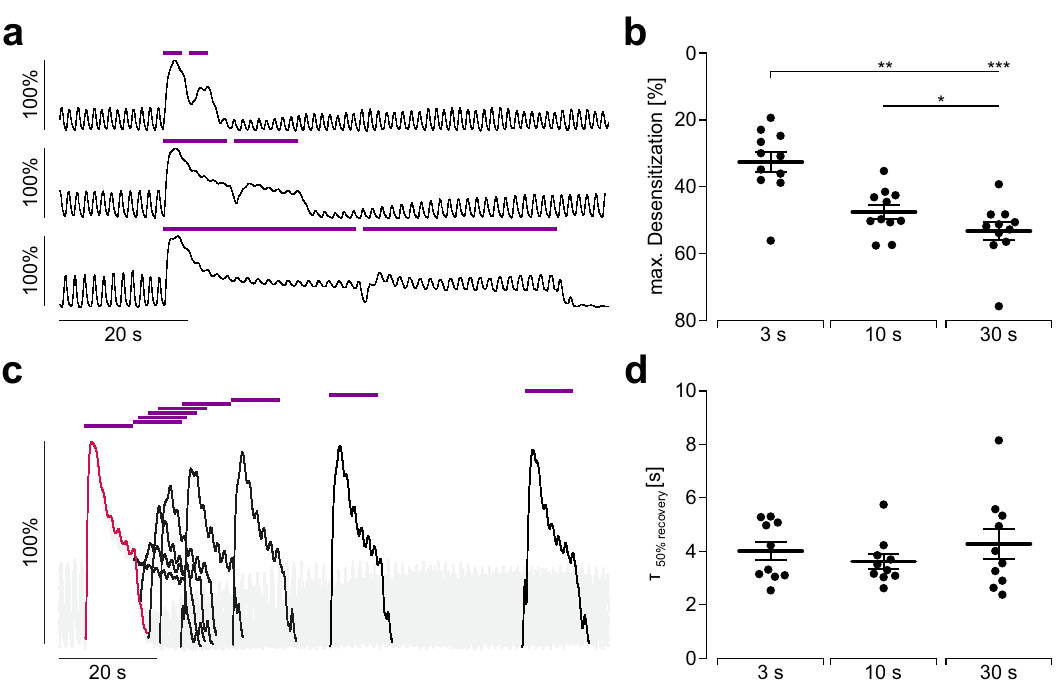
Fig. 10 Desensitization and recovery from desensitization of light-induced force in the small intestine. a , b Representative traces ( a ) and aggregated data ( b ) of isometric force measurements showing the maximum desensitization (relative decrease) of light-induced isometric force in dependence of the applied pulse duration (violet bars, 1 mW/mm 2 , from top to bottom: 3 s, 10 s, 30 s). Statistical analysis was performed with repeated measurements one- way ANOVA with Tukey ’ s multiple comparison test ( N = 4, n = 11; p(3 vs. 10 s): 0.0015; p(3 vs. 30 s): 0.0005; p(10 vs. 30 s): 0.04). c Overlay of